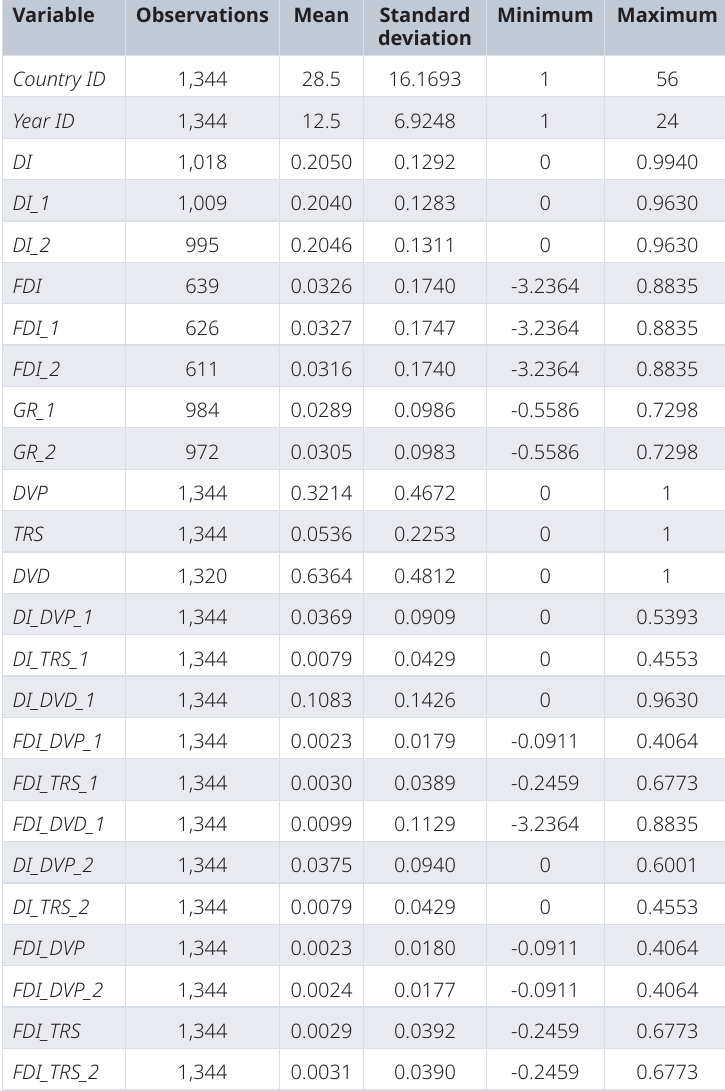
Table 3. Summary